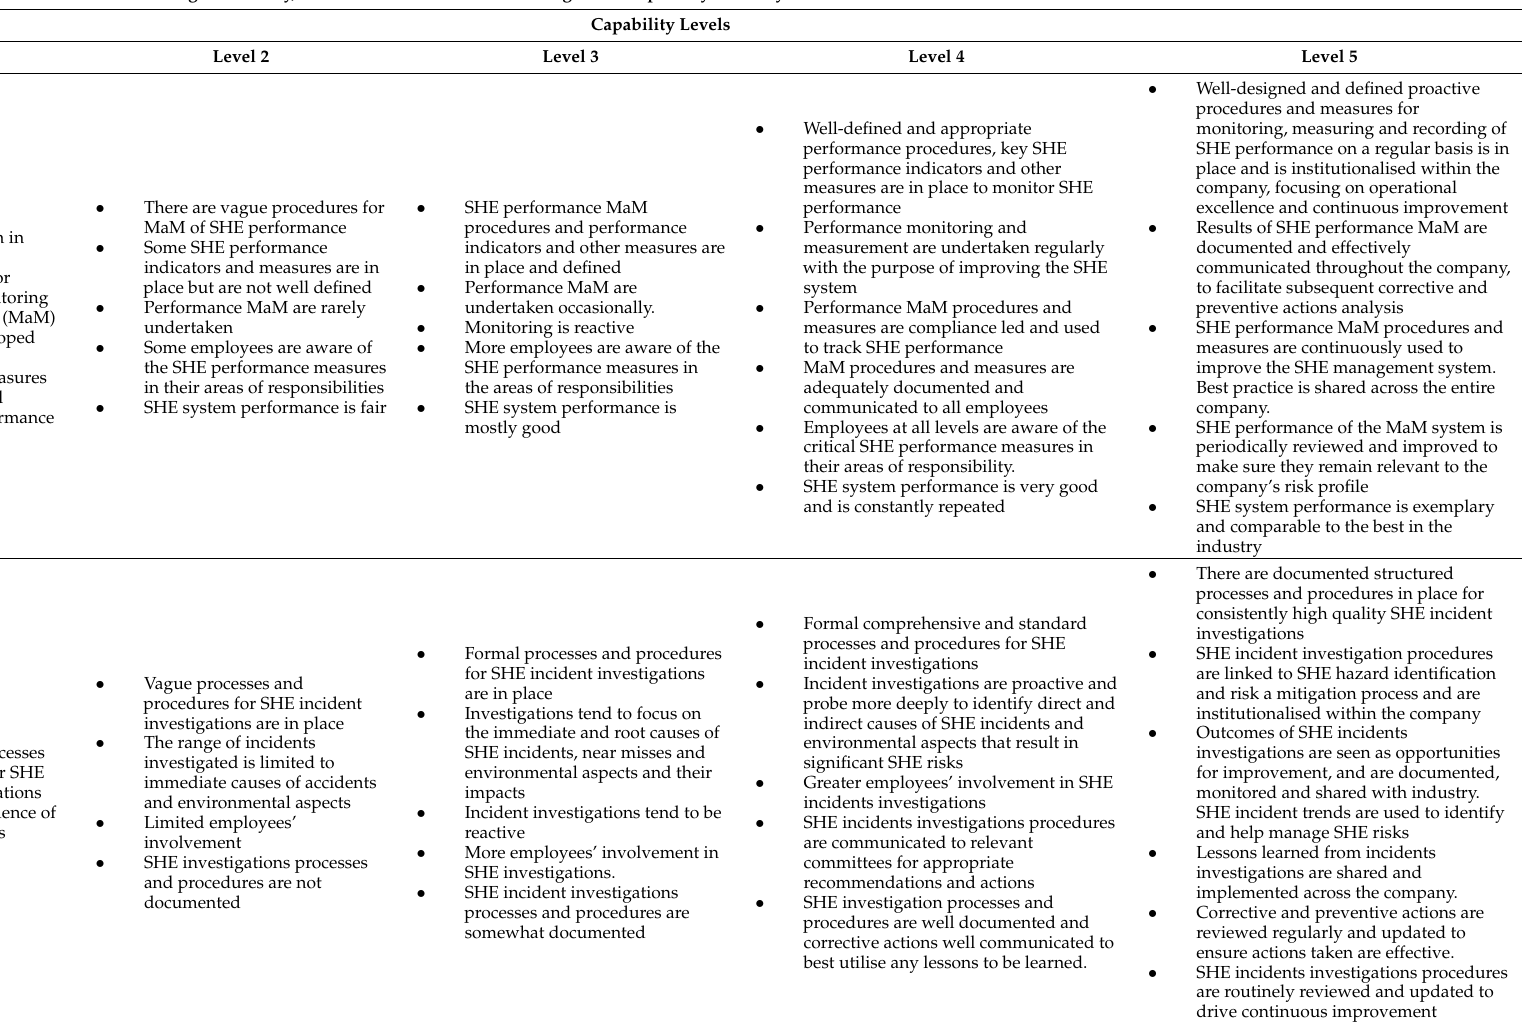
Integrated Safety, Health and Environmental Management Capability Maturity Model